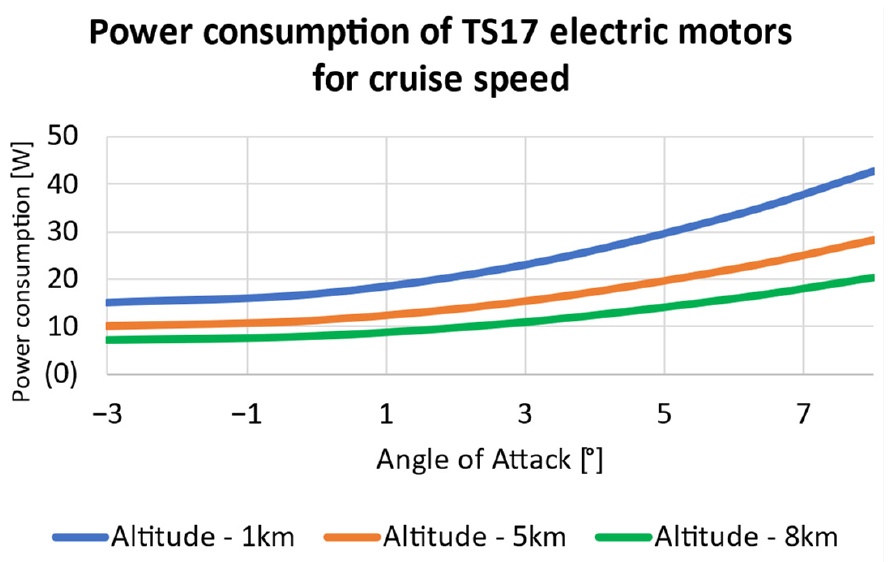
Figure 21. Power consumption of TS17 electric motors for cruise speed.